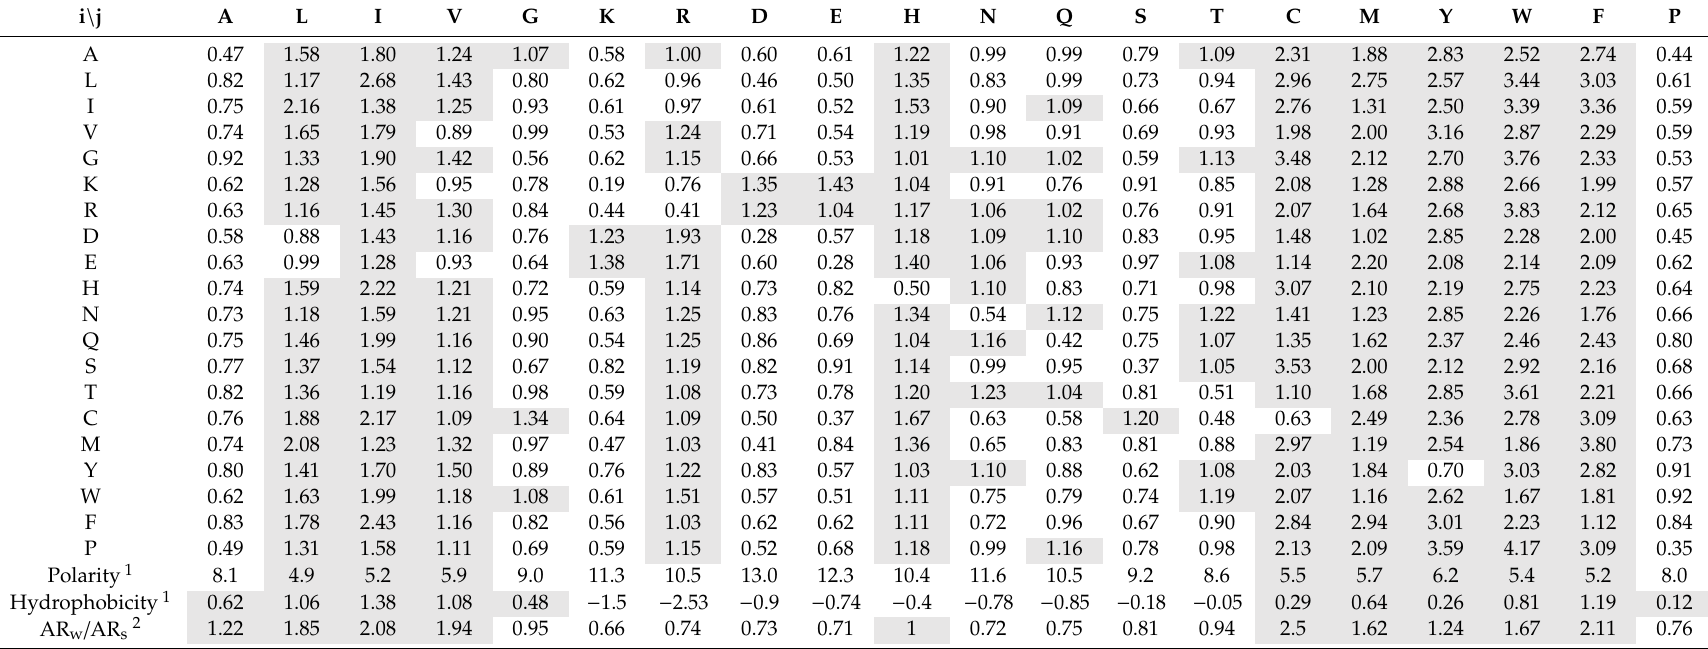
Table 2. Relative abundance of interacting residues (RAIR) scores of residue